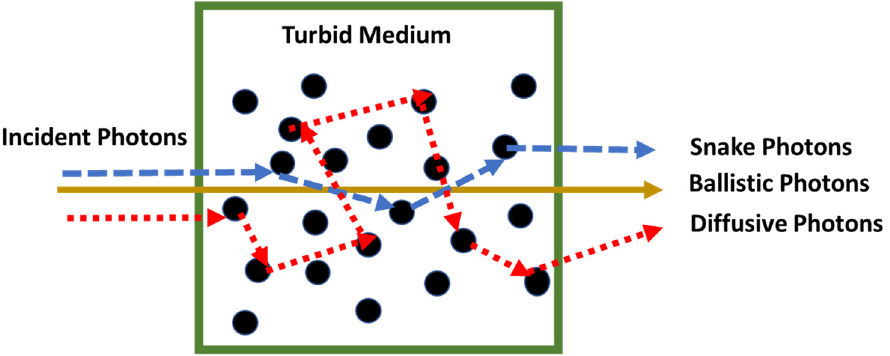
Figure 1. Illustration of photons’ journey in a turbid medium.